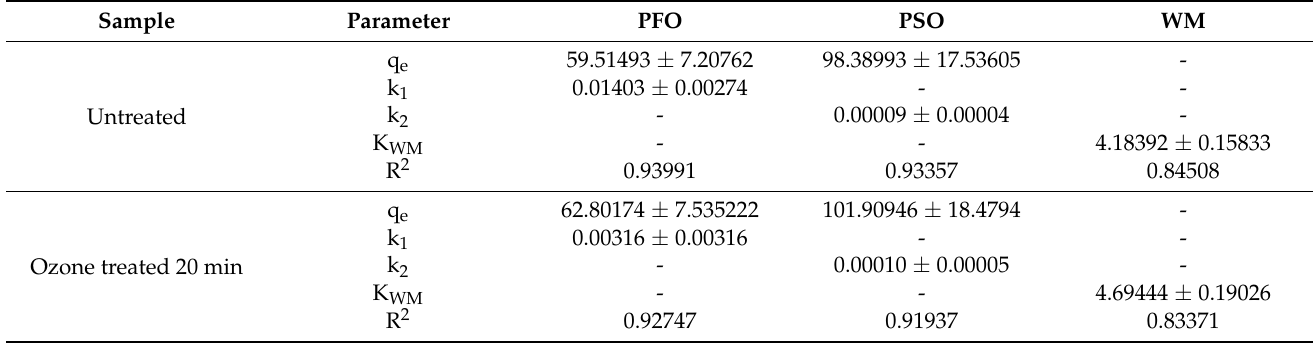
Table 6. Kinetic parameters for the non-linear models of adsorption.